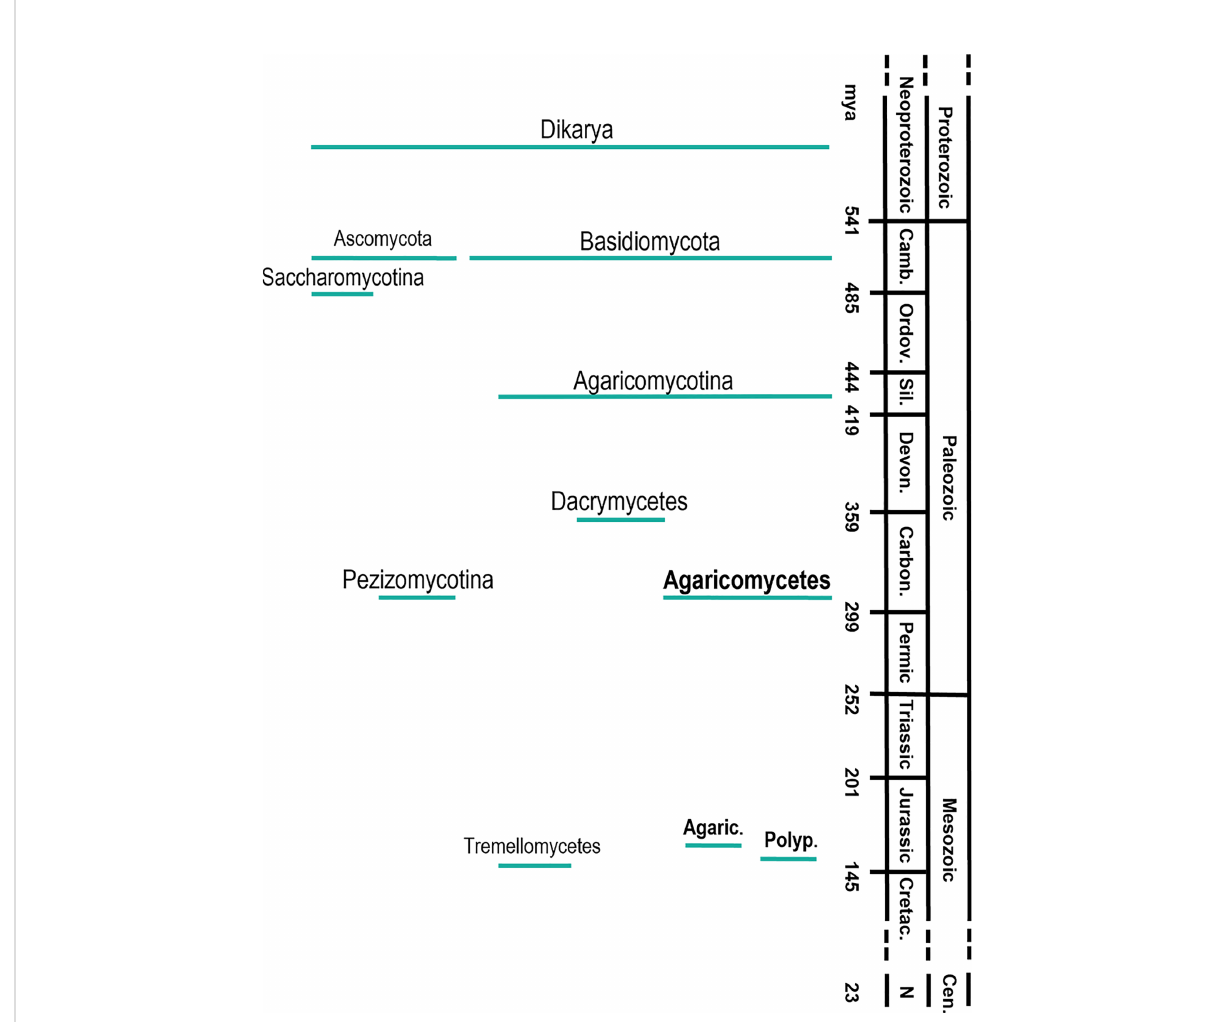
FIGURE 2 Timeline of the main diversi fi cation events in the evolution of wood-decay fungi in the subkingdom Dikaria, phyla Ascomycota and Basidiomycota, subphyla Saccharomycotina, Agaricomycotyna and Pezizomycotina, classes Dacrymycetes, Agaricomycetes and Tremellomycetes and orders Agaricales and Polyporales; Camb., Cambric period; Ordov., Ordovician; Sil., Sillurian; Devon., Devonian; Carbon., Carboniferous; Cretac., Cretaceous; Cen., Cenozoic era; N, Neogene period. Agaric, Agaricales; Polyp, Polyporales. The diversi fi cation times were taken from Floudas et al.